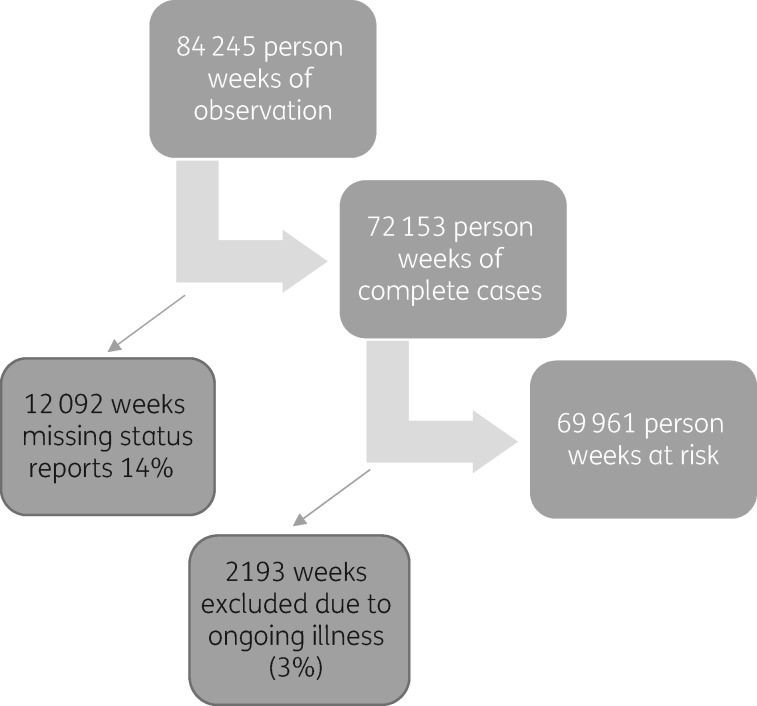
Loss to follow-up.